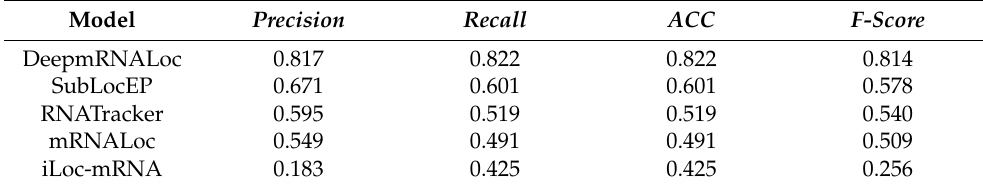
Table 3. Performance comparison of the five models based on the training set (Dataset